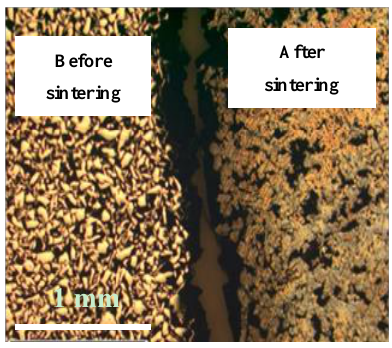
Figure 8. micrography of polished samples before and after sintering at (800 °C) . Figure 8. Micrography of polished samples before and after sintering at (800 ◦